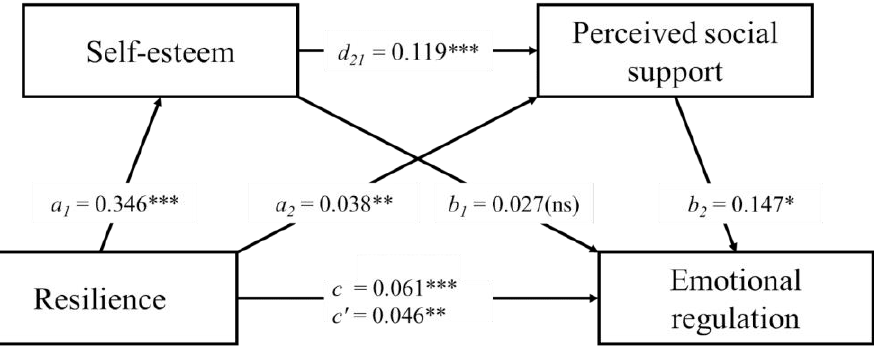
Figure 1. Results of the serial multiple mediational model, *** p < 0.001; ** p < 0.01; * p < 0.05; ns = not significant. Values shown are unstandardized coefficients.